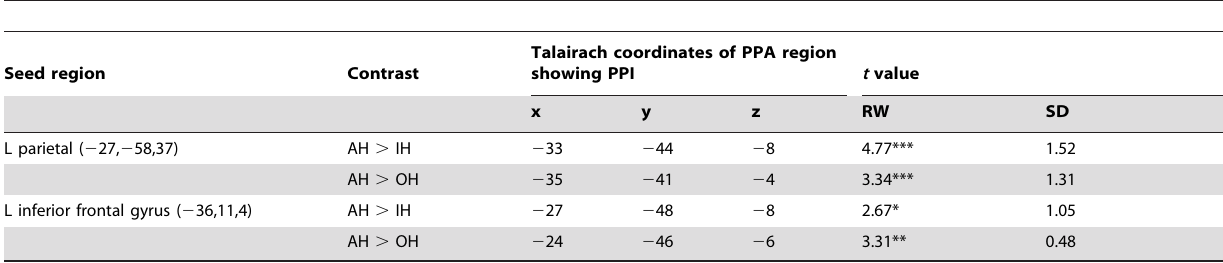
Table 3. Parietal and frontal seed regions showing psychophysiological interaction with the PPA (Talairach co-ordinates shown) under different task